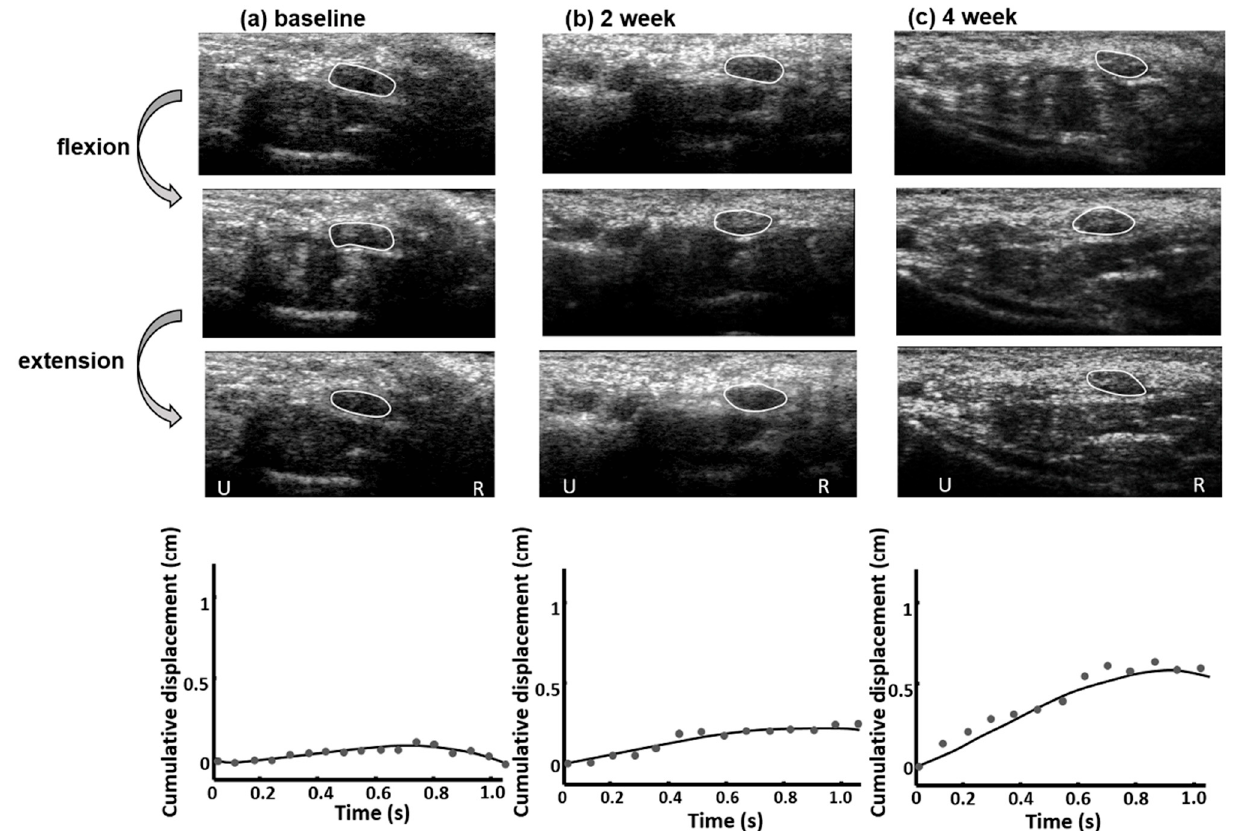
Figure 2. Estimation of the median nerve motion patterns in a CTS patient treated with oral steroids. At ( a ) baseline, ( b ) 2 weeks after, and ( c ) 4 weeks after treatment, the median nerve (white line) showed different transverse sliding motions over the ulnar-radial plane during finger flexion and extension movements. Cumulative displacement of the median nerve at different acquisition times during one finger flexion–extension cycle indicated the motion pattern. The dots represent the cumulative displacements at different acquisition times and the lines indicate the fitted curves for the baseline, 2 weeks after, and 4 weeks after treatment, respectively. U: ulnar side; R: radius side.